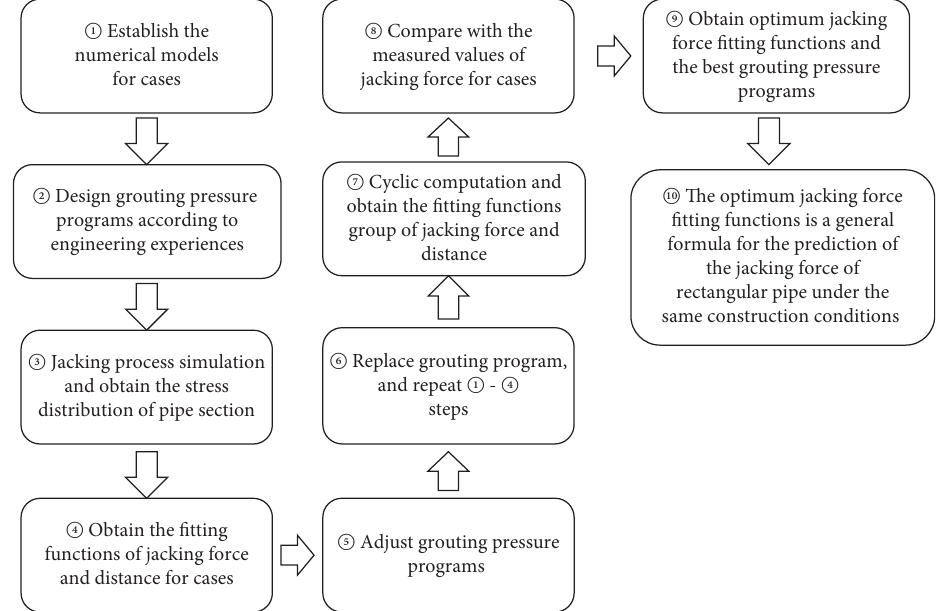
Figure 8: Jacking force estimation flow